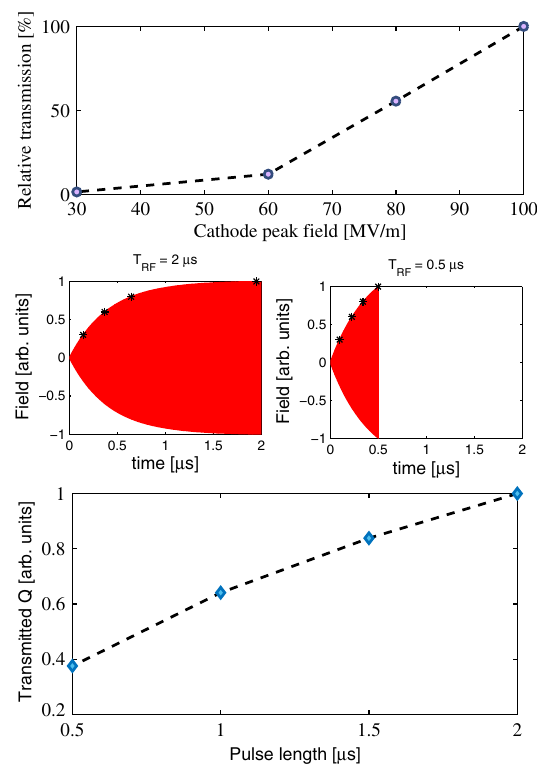
FIG. 15. Top plot: transmission to the end of the second accelerating cavity of the dark current as a function of the gun peak field. Middle plots: rf pulse assumed in the simulations assuming different pulse lengths. The buckets considered are also indicated. Bottom plot: expected transmission of the dark current to the end of the second accelerating cavity as a function of the rf pulse length normalized to the case corresponding to 2 μ s rf